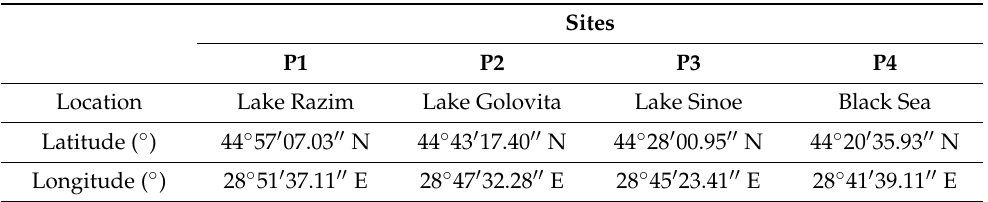
Table 1. The location of the four chosen sites.